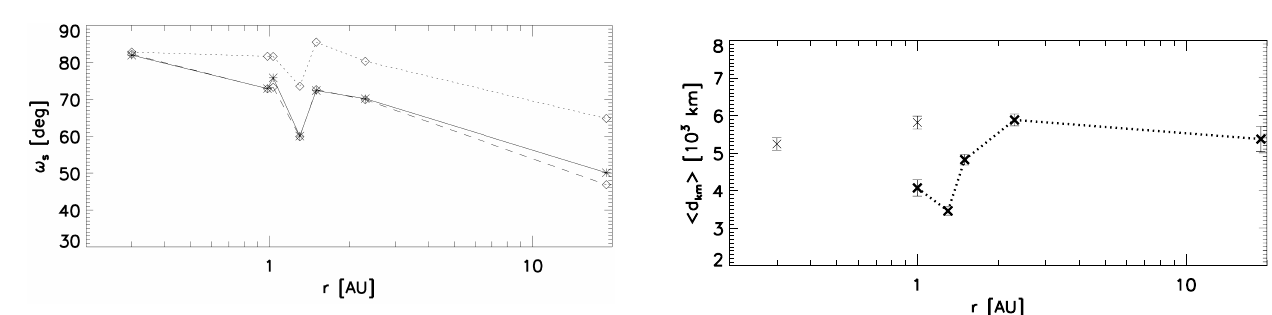
Fig. 11. Relative frequency of ω for Helios 2 (top) and Voyager 2 (bottom) as a histogram; thin solid line is a fit to the distribution pro- portional to exp [− (ω/ω s ) 2 ] ; the mean h ω i is dotted and the median ⊂ ω ⊃ dashed shown.